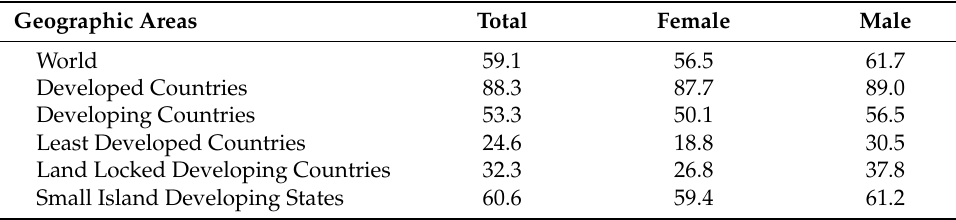
Table 2. Percentage of individuals using the Internet, by sex (2020). Geographic Areas Total Female Male World 59.1 56.5 61.7 Developed Countries 88.3 Developing Countries Least Developed Countries Land Locked Developing